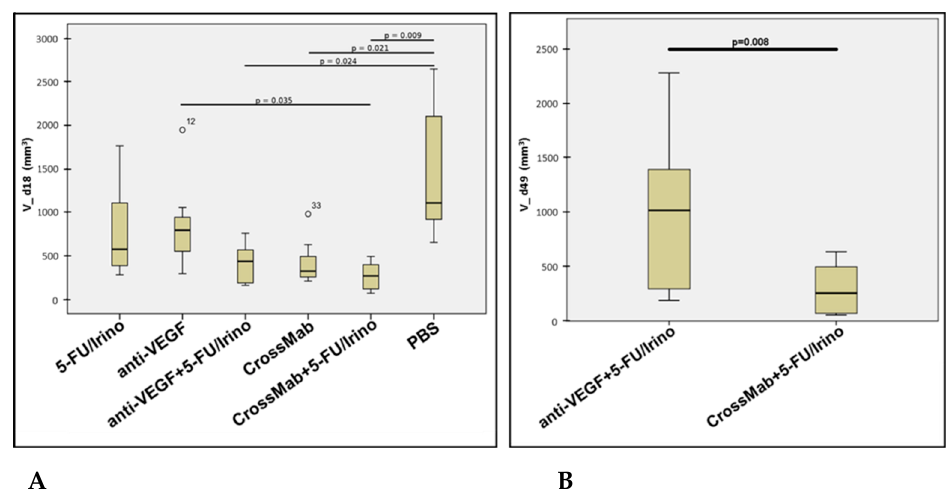
Figure 3. Statistical analysis of tumor volumes ( A ) on day 18 (V_d18) comparing all groups (ANOVA, Post Hoc Dunett-T3) and ( B ) comparing both combination therapy groups on day 49 (V_d49) after completion of study (Student’s T-Test).